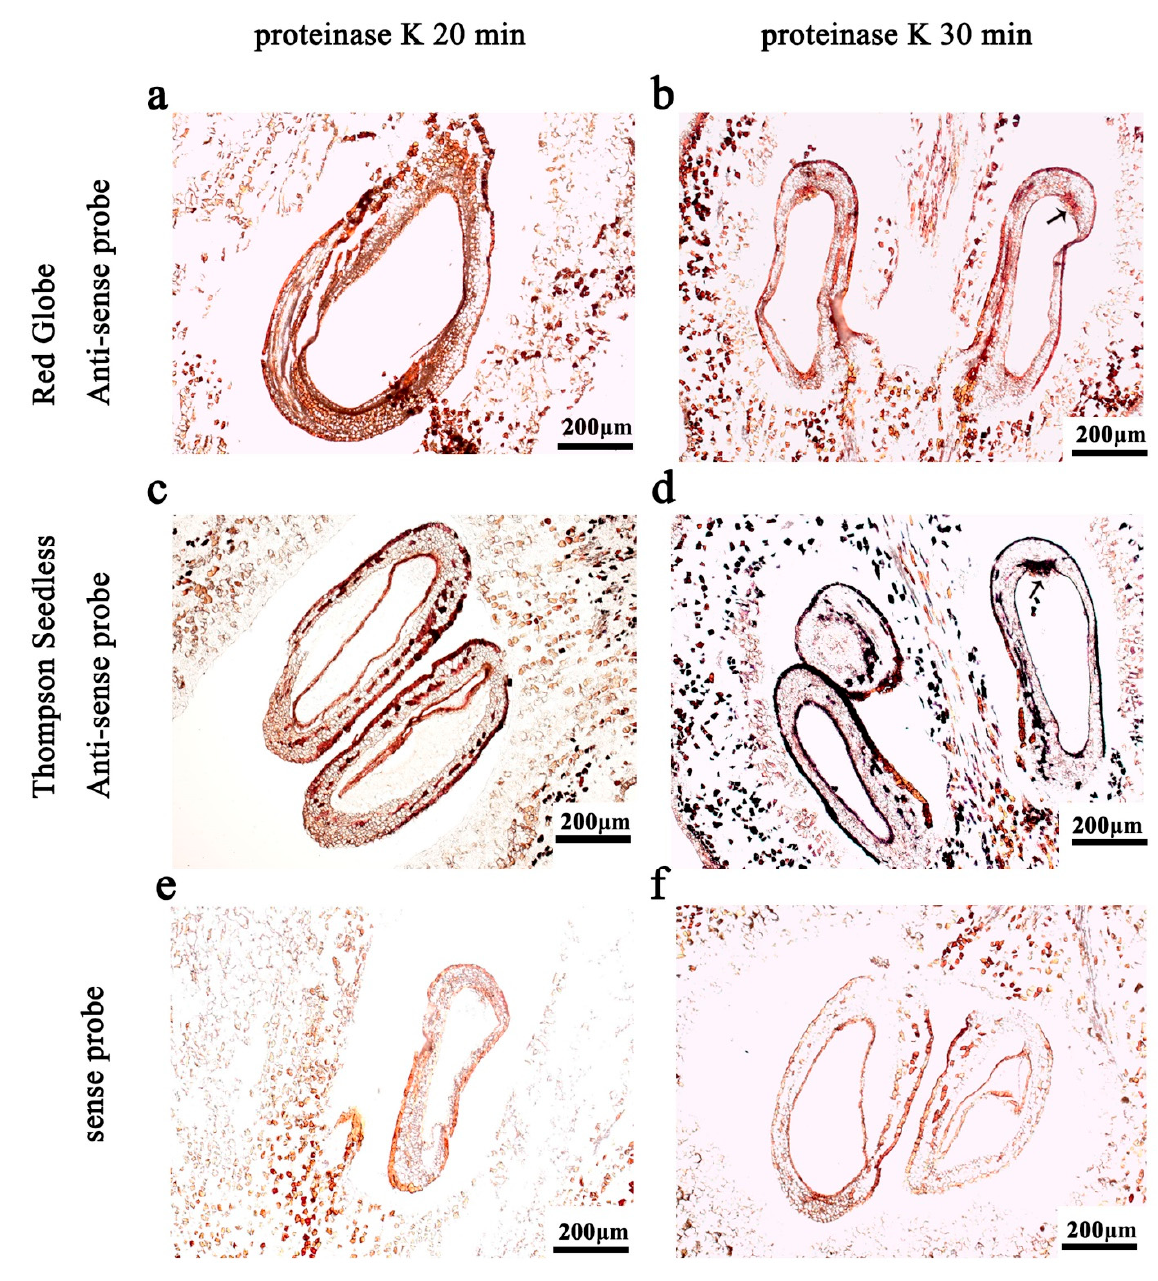
Figure 1. The in situ hybridisation with different digestion times of protease K: 1 µ g/mL of protease K digested at 37 ◦ C for 20 min ( a , c , e ) and 30 min ( b , d , f ). ( a , b ) antisense probe, 10 DAF in ‘Red Globe’; ( c , d ) antisense probe, 10 DAF in ‘Thompson Seedless’; ( e , f ) sense probe. DAF: days after flowering. The ISH signal is evidenced by purple staining and indicated by a black arrow.